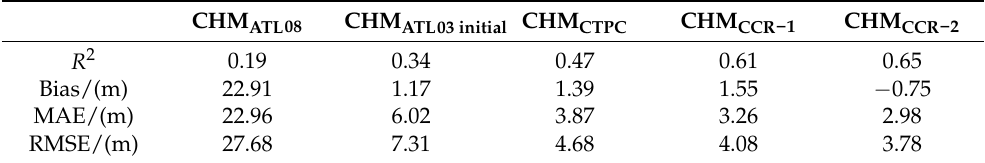
Figure 9. Comparison of airborne and spaceborne canopy height estimates retrieved by different methods: ( a ) is the result of CHM ATL08 , CHM ATL03 initial , CHM CTPC and CHM CCR – 2 , ( b ) is the result of CHM CCR – 1 , CHM CCR – 2 and CHM ALS . Table 3. Accuracy of tree height inversion for different